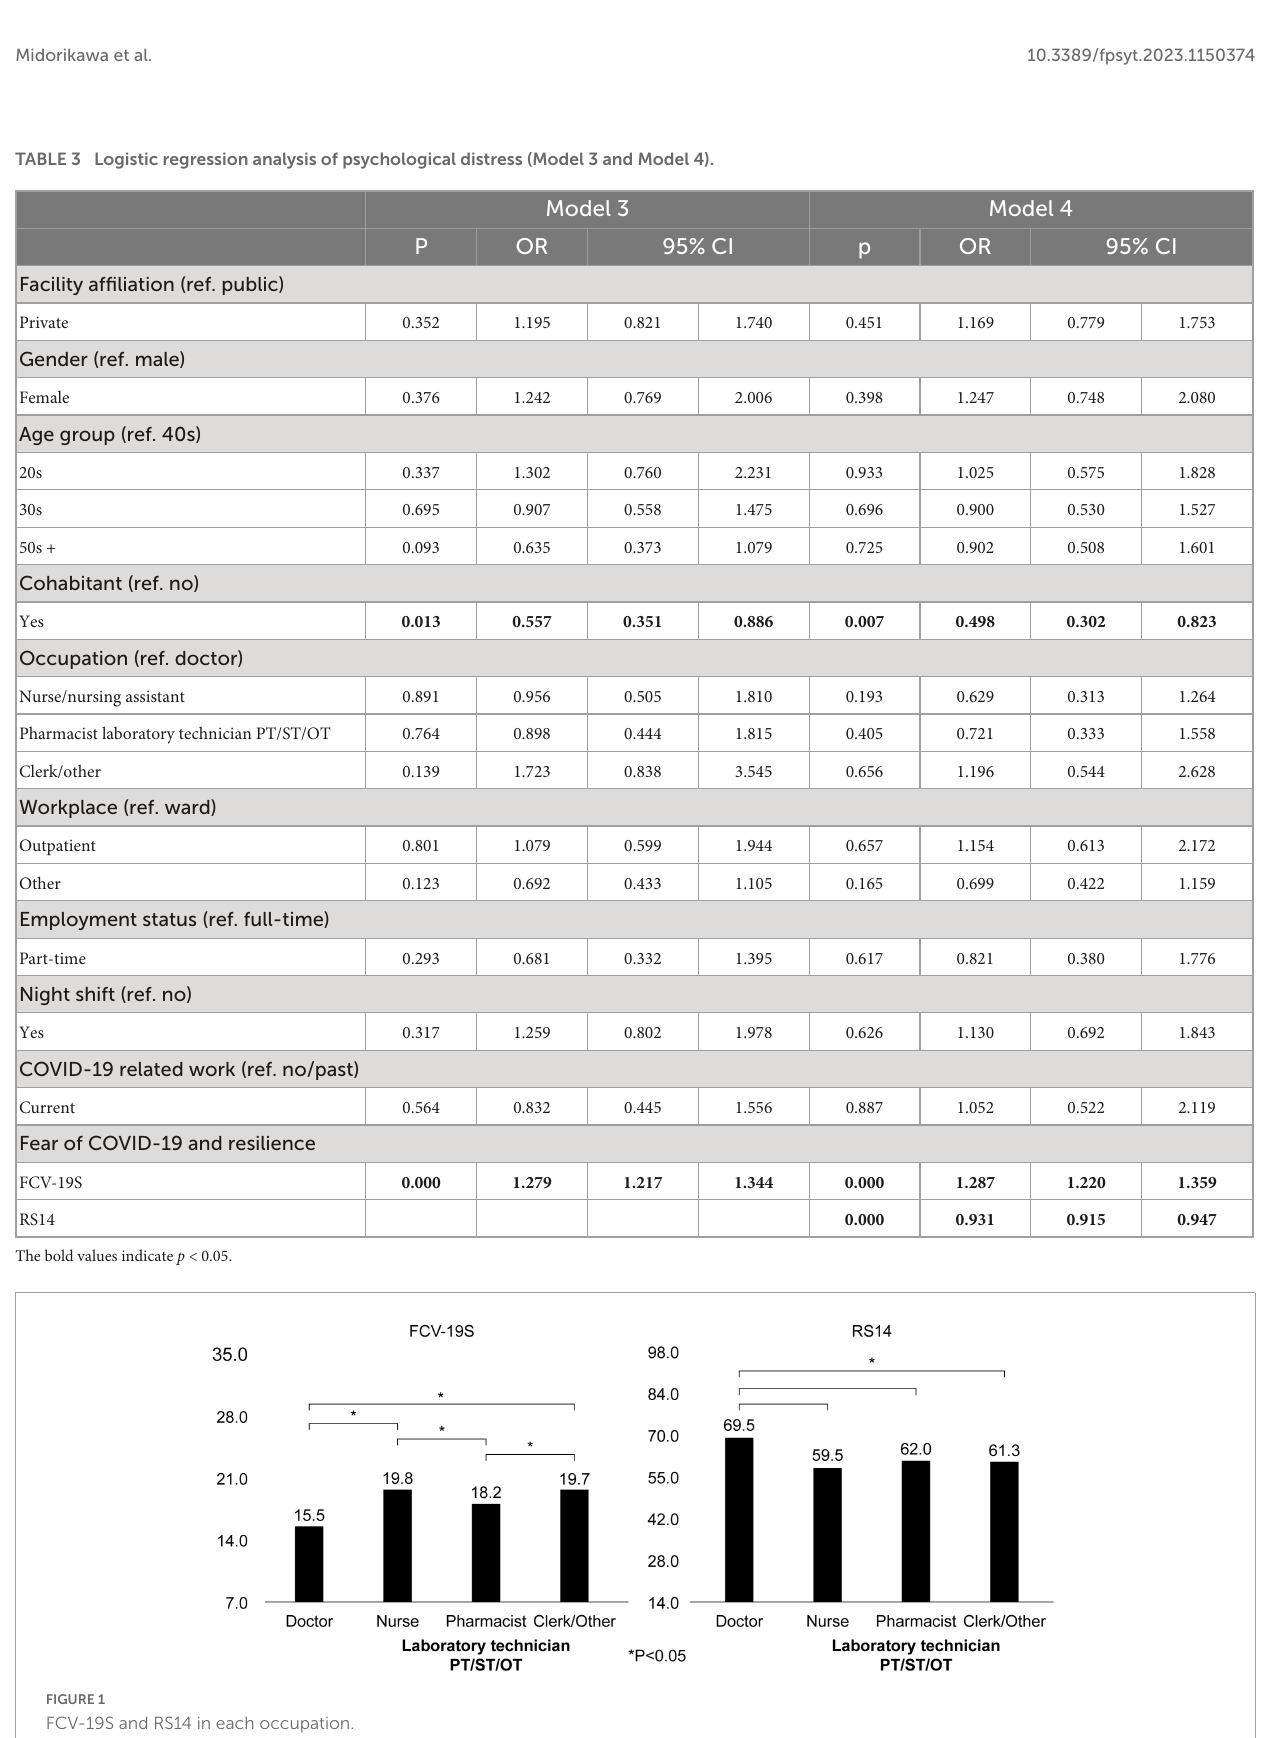
that doctors are less resilient than other occupations (39). The relationship between occupation in HCWs and their resilience may differ across countries, and further research is needed to examine